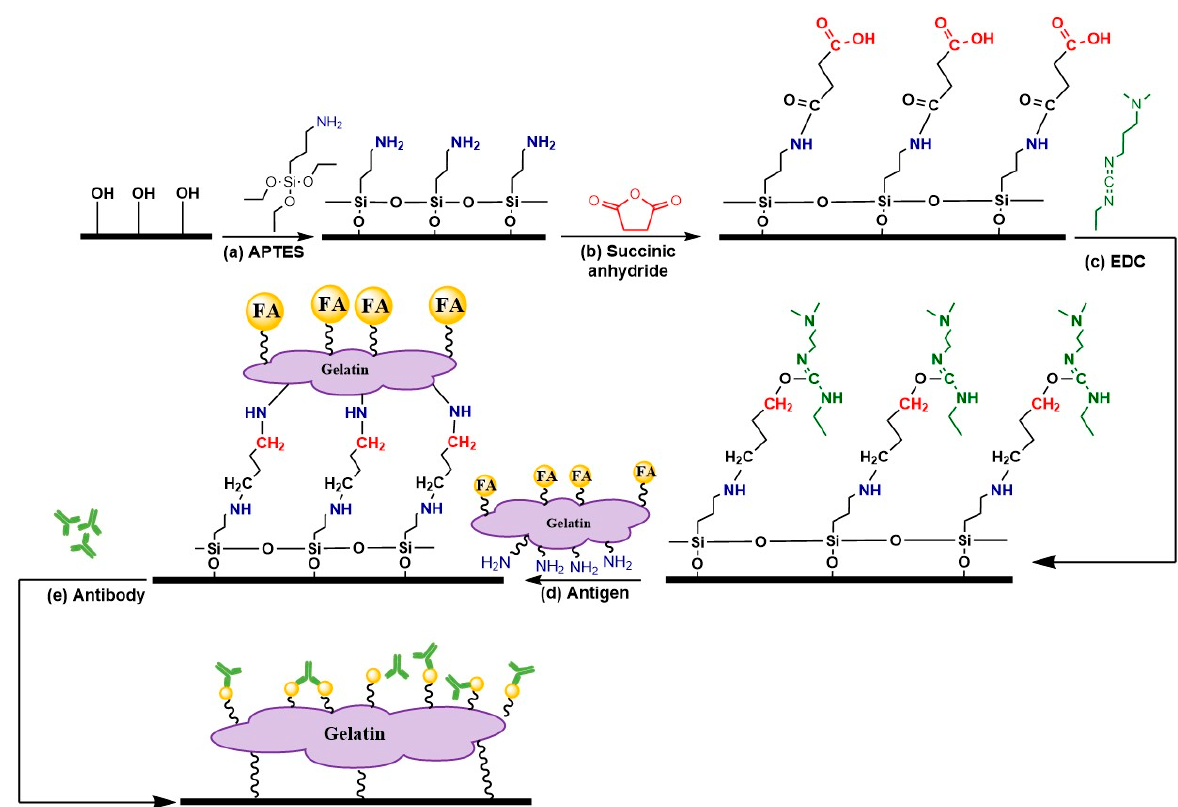
Figure 1. Chemical modifications of the glass chip surface for measuring folic acid: ( a )